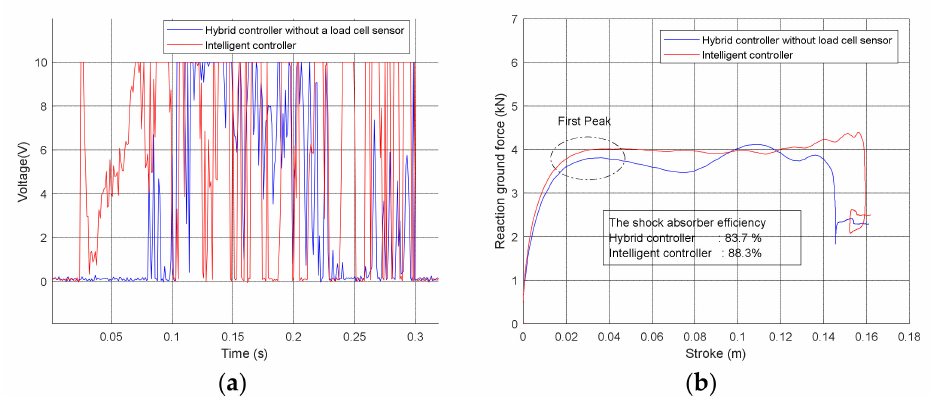
Figure 16. ( a ) Voltage applied to MR core, ( b ) efficiency curve. The performance of the landing gear using the hybrid controller without exact data and intelligent controller in the case of m 1 = 230 kg, v = 1